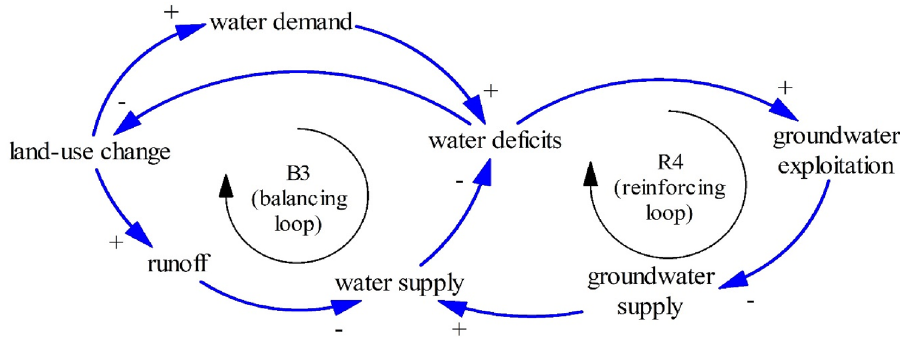
Figure 10. The Limits to Growth #3.